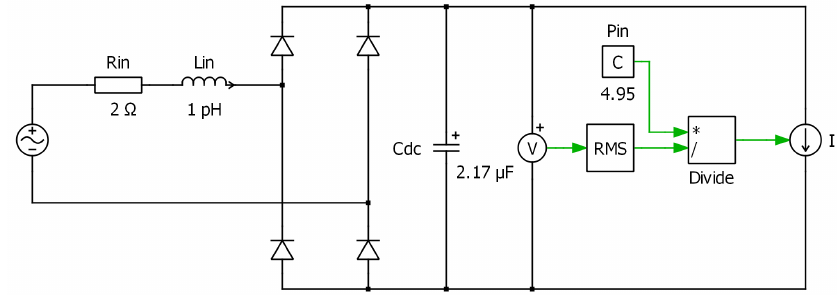
Figure A1. Time domain circuit model of the Type A LED lamp.